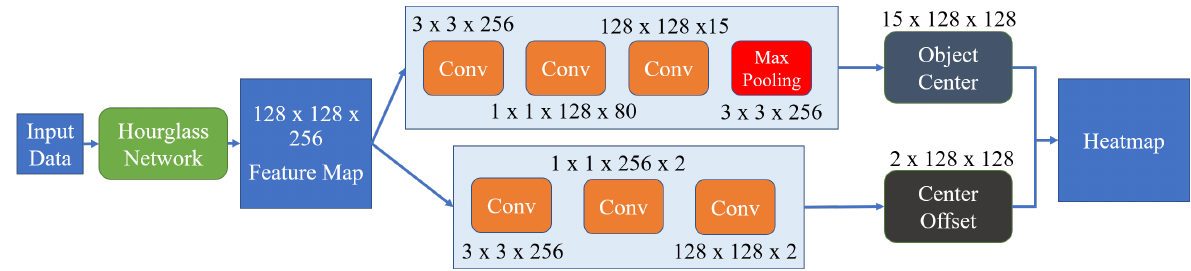
Figure 2. The network architecture for the key-point